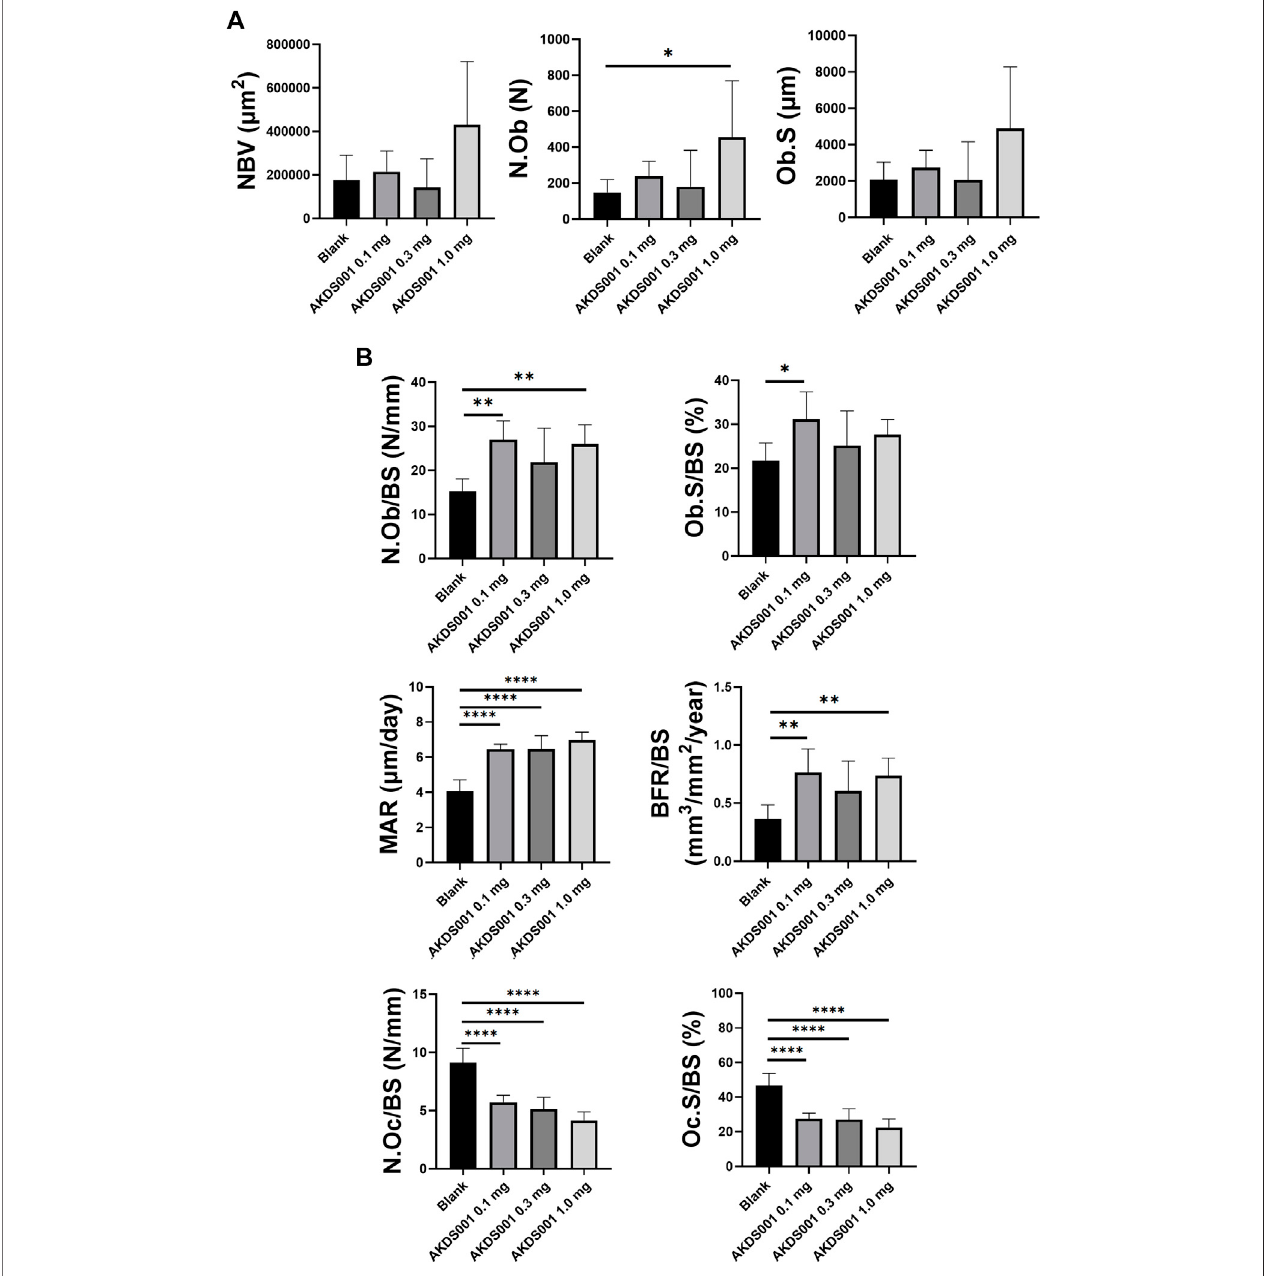
FIGURE 6 | Histomorphometric analysis of Blank MS versus AKDS001 MS (0.1, 0.3, 1.0 mg/ml). (A) New bone volume (NBV), number of osteoblasts (N.Ob) and osteoblastsurface(Ob.S). (B) N.Ob/bonesurface(BS),Ob.S/BS,mineralappositionrate(MAR)andboneformationrate(BFR)/BS onnewbone.Numberofosteoclasts (N.Oc)/BS and osteoclast surface (Oc.S)/BS on xenografted bone. Blank MS, n = 6; AKDS001 MS 0.1 mg/ml, n = 6; AKDS001 MS 0.3 mg/ml, n = 6; AKDS001 MS 1.0 mg/ml, n = 6. * p < 0.05, ** p < 0.01, *** p < 0.001, **** p < 0.0001 by Dunnett ’ s test.